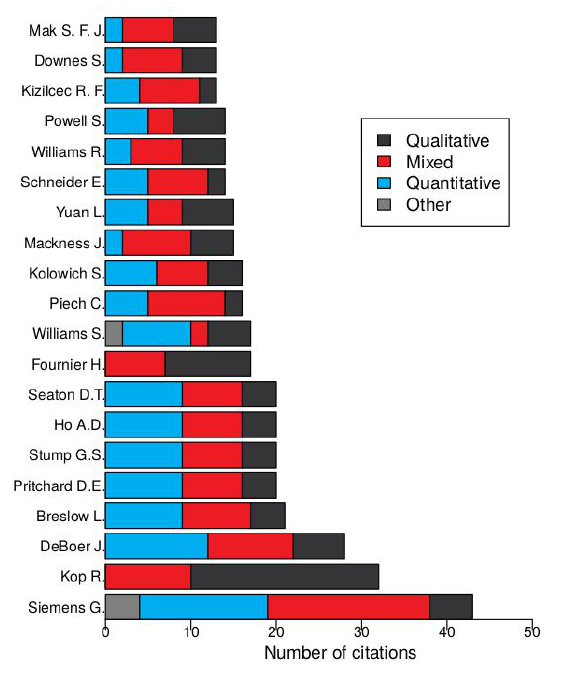
Figure 2 . Phase 1 most cited